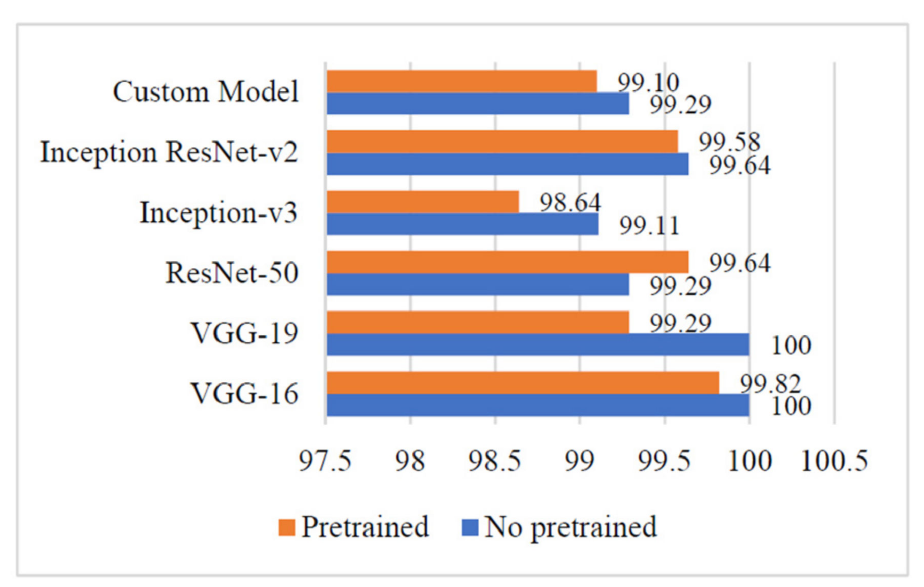
Figure 8. Precision of different deep learning